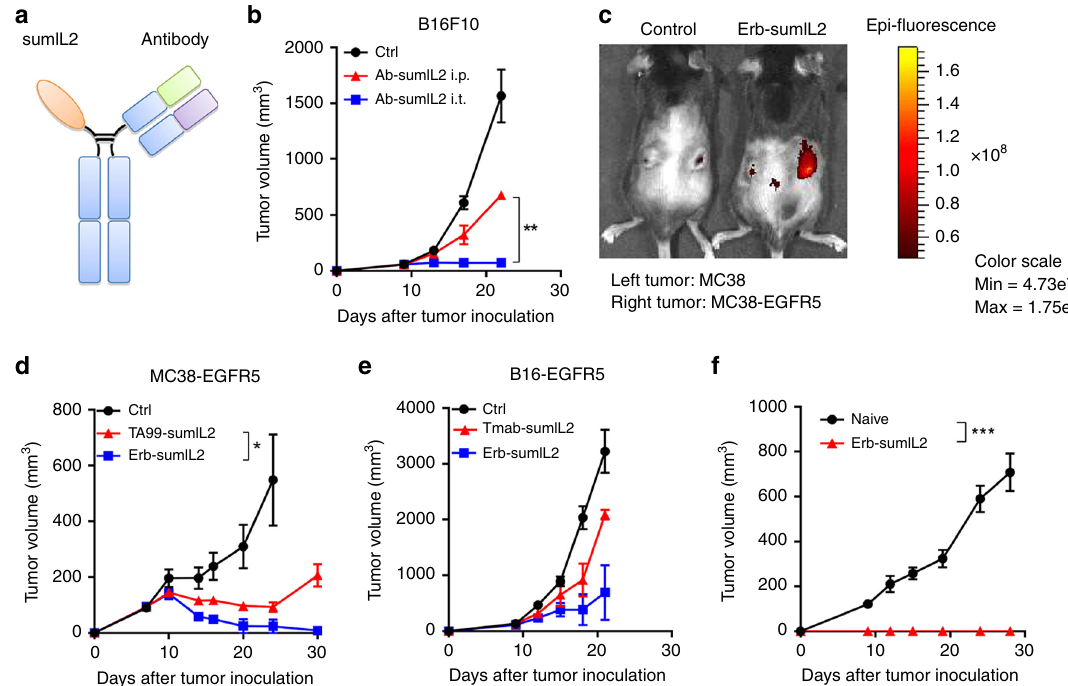
Fig. 2 Targeting sumIL-2 to tumor site signi fi cantly improves its therapeutic effect. a The schematic model of Erb-sumIL2. SumIL-2 is fused to the Fc and forms heterodimer with anti-EGFR. b C57BL/6 mice ( n = 3 – 5/group) were injected subcutaneously with 5 × 10 5 of B16F10 tumor cells, and 10 μ g of Erb- sumIL2 was administered intraperitoneally (i.p.) or i.t. on days 9, 13, and 17. The growth of the tumor was measured and compared twice a week. c Fluorescence images of MC38(left) and MC38-EGFR5(right) tumor-bearing mice treated with a single dose of PBS or 25 μ g Erb-sumIL2 (i.v.). d C57BL/6 mice were ( n = 5/group) injected subcutaneously with 5 × 10 5 of MC38-EGFR5 cells, and then i.v. treated on days 7 and 10 with PBS, 25 μ g of Erb-sumIL2 or 25 μ g TA99-sumIL2. e C57BL/6 mice ( n = 3 – 5/group) were injected subcutaneously with 5 × 10 5 B16-EGFR5 cells, and then i.v. treated on days 9, 12, and 15 with PBS, 25 μ g of Erb-sumIL2 or 25 μ g Tmab-sumIL2 (anti-Her2-sumIL2). f WT C57BL/6 mice or mice with tumor clearance by Erb-sumIL2 ( n = 5/ group) were injected subcutaneously with 3 × 10 6 of MC38-EGFR5, and the growth of the tumor was measured and compared twice a